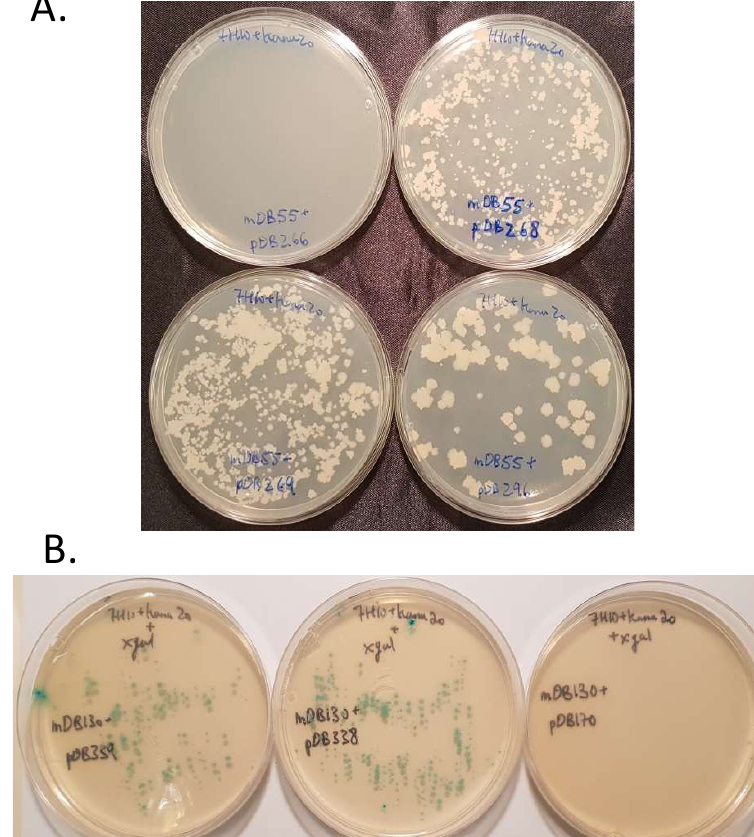
Figure 6. ( A ) when MapA is present, MapB can be replaced with MapB V18G (pDB268, top right), MapB W255L (pDB269, bottom left) or MapB V18G;W255L (pDB296, bottom right), however not completely removed (pDB266, empty vector. Top left). ( B ) On the background of mapA deletion, MapB can still be replaced by MapB V18G (pDB338, middle plate), MapB W255L (pDB339, left plate) and not an empty vector (pDB170, right plate). All three plasmids (pDB170, 338, 339) also carry a lacZ gene for additional visual selection on top of kanamycin resistance.